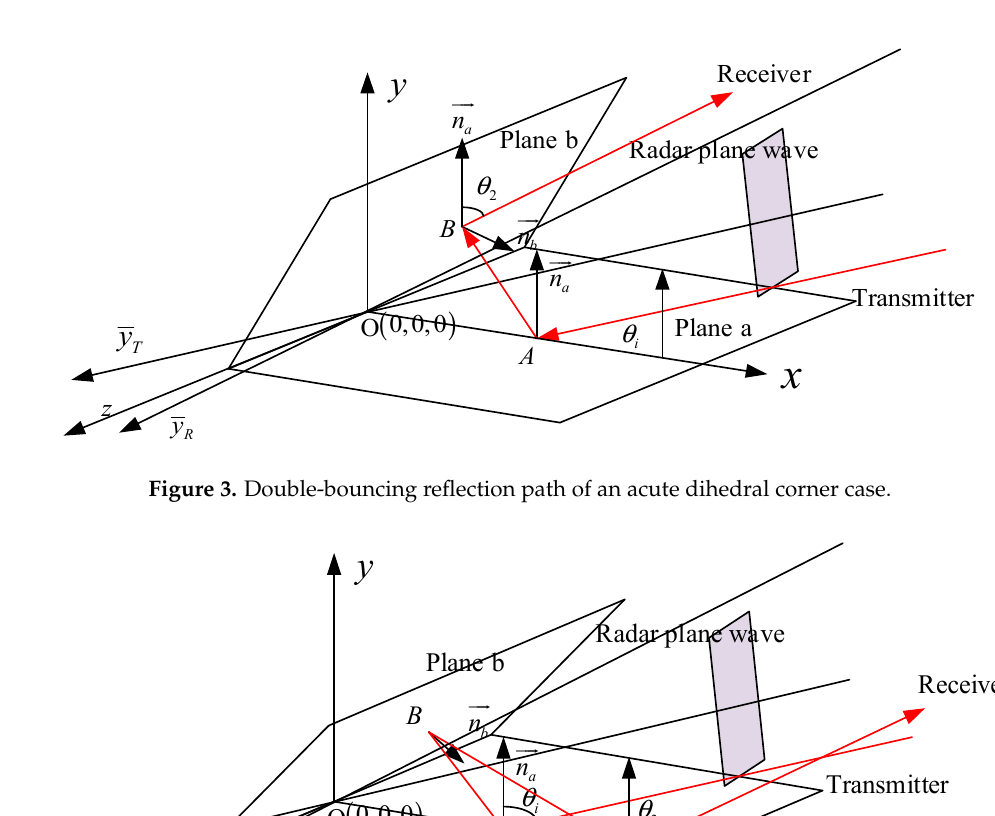
Figure 3. Double-bouncing reflection path of an acute dihedral corner case.